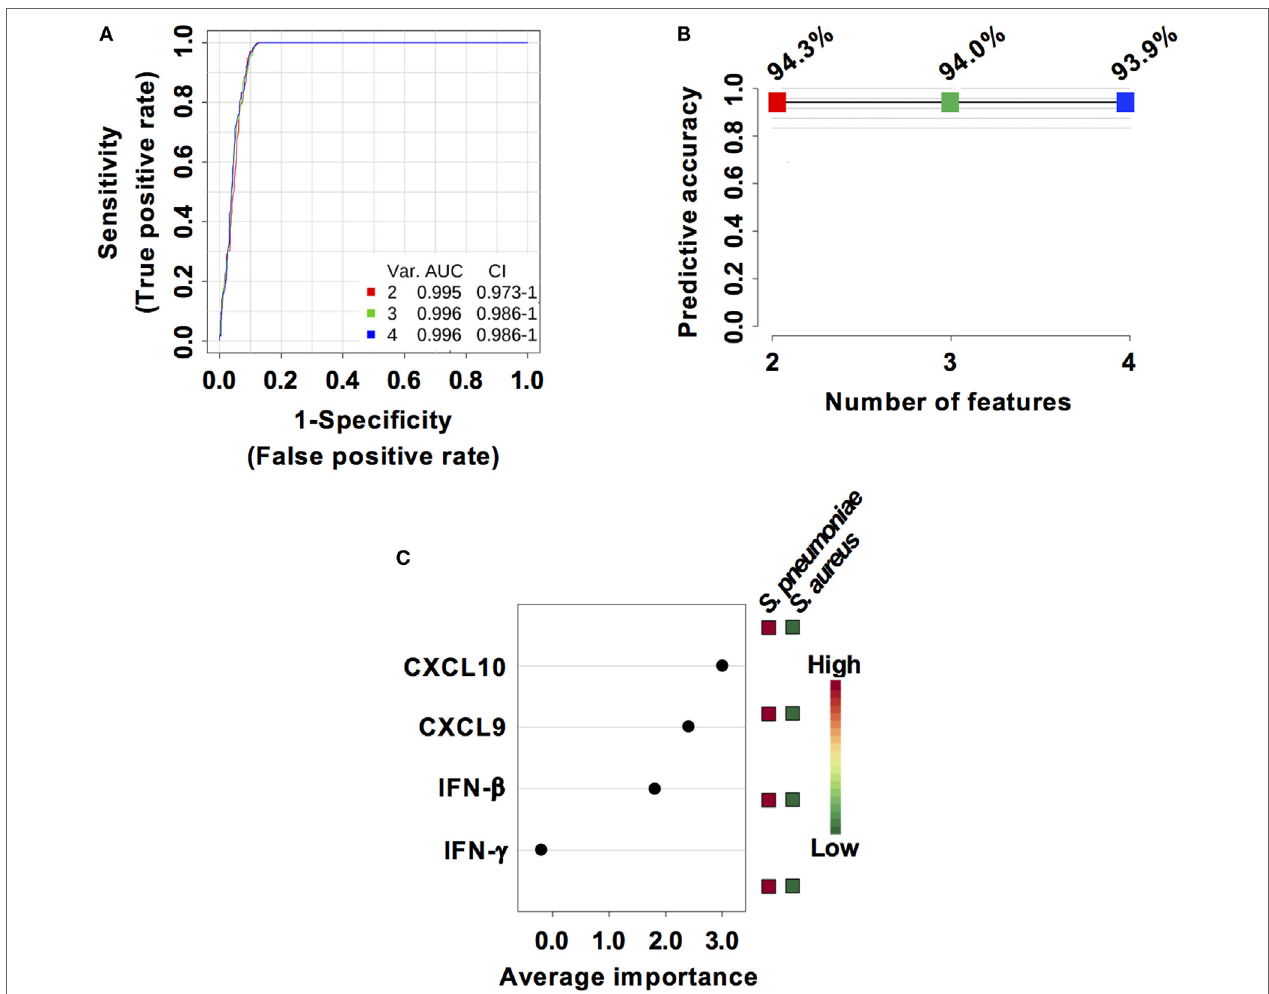
FigUre 6 | Predictive models based on IFN- β , IFN- γ , CXCL9, and CXCL10 serum levels built by support vector machine (SVM). (a) Receiver operating characteristic curves and area under the receiver operating characteristics curve (AUC) values of the predictive classifiers built on 2, 3, and 4 features using an SVM. (B) Predictive accuracy of the different predictive models. (c) Average importance of each of the four features included in the predictive models and abundance in Streptococcus pneumoniae and Staphylococcus aureus infection